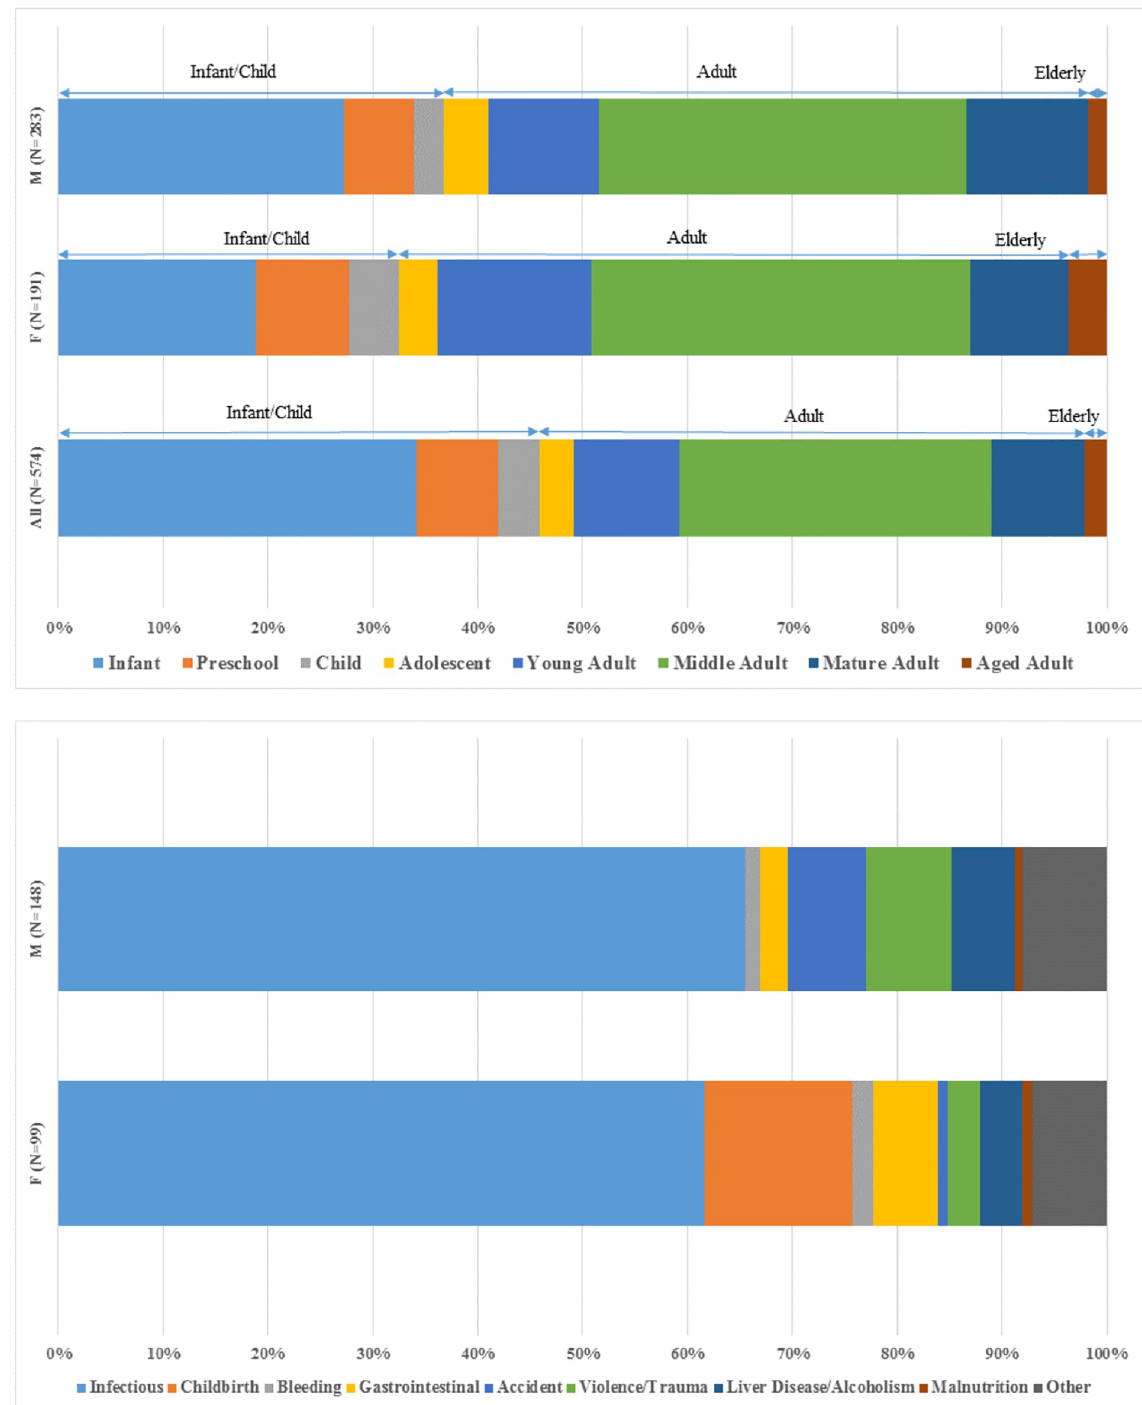
Fig 4. (a) Demographic distribution of the Christ Church burials . Note that individuals of unknown age (N = 31) are not included. (b) Recorded causes of death for Christ Church burials (males and females aged 13–45) . All data from S1 Table.